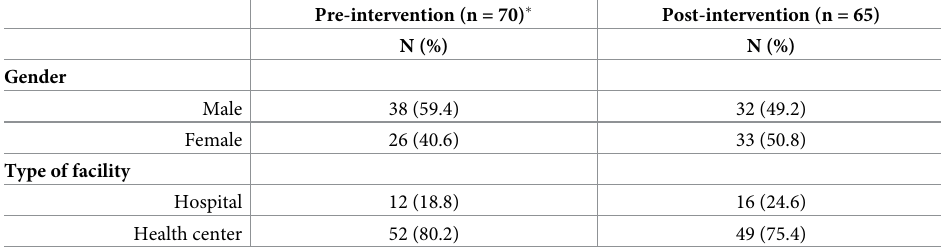
Table 7. Characteristics of participants in HCW FGDs, pre- and post-